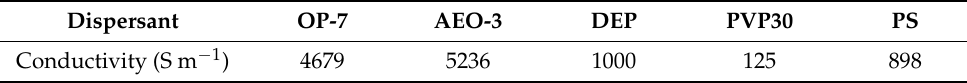
Table 4. Conductivity of RGO with different dispersants.